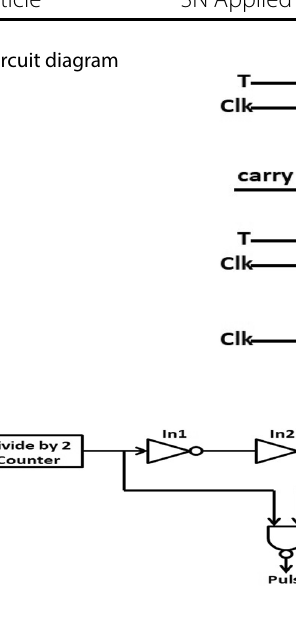
Fig. 7 Pulse generator circuit [10]